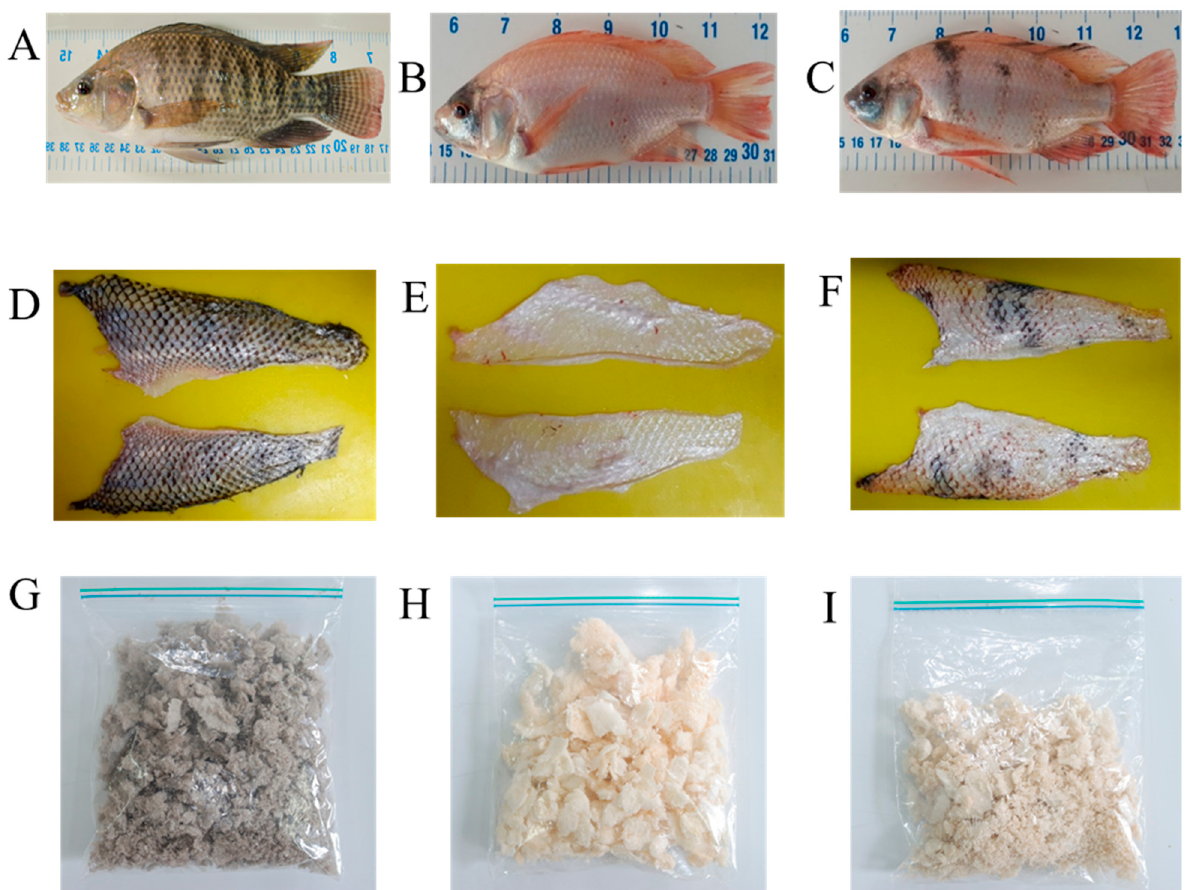
Figure 1. Tilapia genetic strain ( Oreochromis niloticus ). ( A ) Gray XX, ( B ) Red YY, ( C ) F1 XY, and ( D ), ( E ), and ( F ) are gray, red, and F1 skins, respectively; ( G ), ( H ), and ( I ) are lyophilized collagens from gray, red, and F1 fish, respectively. Table 1. Weight of fillet and subproducts of F1 XY.